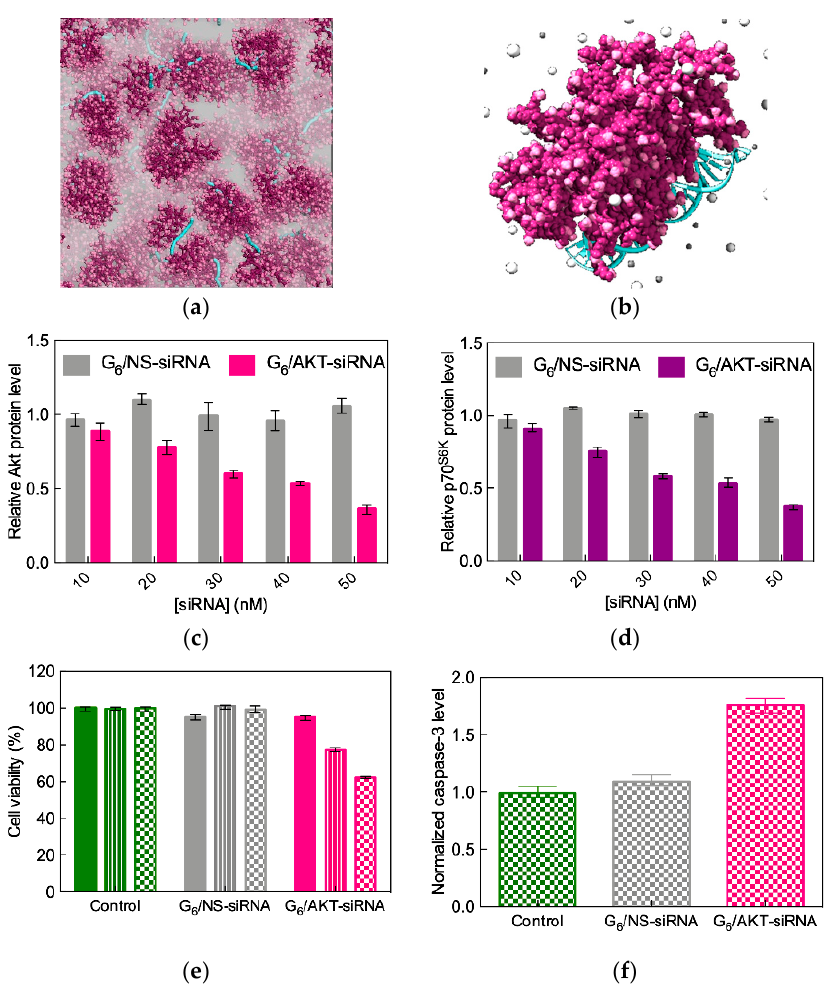
Figure 8. ( a ) Simulation of G 6 TEA-core PAMAM dendrimers in complex with AKT siRNA at N/P = 5. The dendrimers are portrayed as wine-colored spheres, with charged amine groups depicted in pink. siRNA molecules are shown as turquoise sticks. A transparent gray field is used to represent the solvent environment. ( b ) Zoomed view of one single G 6 TEA-core PAMAM molecule in complex with one AKT siRNA (colors as in panel a). Some Cl - and Na + counterions are shown as white and light gray spheres, respectively; water molecules are not shown for clarity. siRNA concentration-dependent inhibition of AKT ( c) and its downstream effector p70 6SK ( d ) in SKOV-3 cells three days after TEA-core G 6 -mediated delivery (N/P = 5). Data for non-specific (NS) siRNA–G 6 complexes are shown for comparison. Protein expression levels were determined by western blotting, quantified by densitometry, and are expressed as fold-change normalized to β -actin. ( e ) Time-dependent growth inhibition of SKOV-3 cells transfected with G 6 TEA-core PAMAM dendrimers (N/P = 5) and with non-specific (NS) siRNA–G 6 complexes, as determined by the MTT assay. Values are expressed as % relative to control (non-treated cells). Filled bars: 24 h post transfection (p.t.), striped bars: 48 p.t., checked bars: 72 h p.t. ( f) Caspase-3 activation in SKOV-3 cells determined 72 p.t. with G 6 TEA-core PAMAM dendrimers at N/P = 5. Data for non-specific (NS) siRNA–G 6 complexes are shown for comparison. Values are expressed as fold change normalized to β -actin used as control. Adapted from [47], which is an open access article published under an ACS AuthorChoice License.